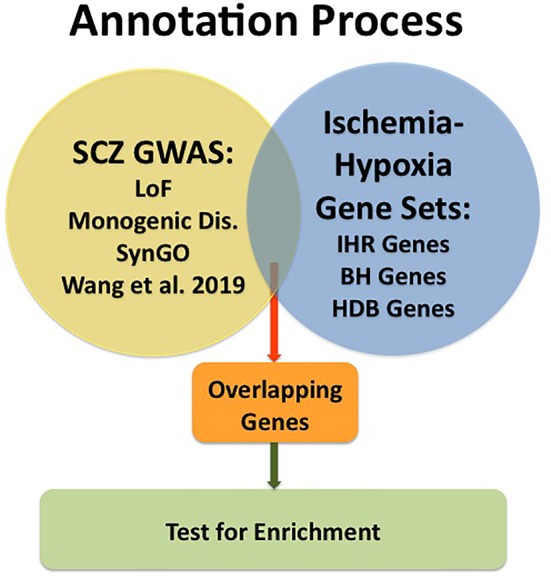
Graphic presentation of the annotation process. GWAS data for schizophrenia (SCZ GWAS) were taken from Pardinas et al. [ref. (23)] and subsets of genes were formed for Loss of Function [LoF; ref. (24)], for Monogenic Disorders (Monogenic Dis.; described under Materials and Methods), for synaptic genes collected in SynGO [ref. (27)] and for a subset described by Wang et al., 2019 [ref.(28)]. Gene sets related to Ischemia-Hypoxia were taken from our database named “ischemia-hypoxia response genes” [IHR Genes; refs. (16, 17)], from the RNAseq study of Bhattarai et al., 2019 [BH Genes; ref. (30)] and from the public database named HypoxiaDB [HDB Genes; ref. (31)]. Overlapping genes were determined, and enrichment tested using Chi-square tests.